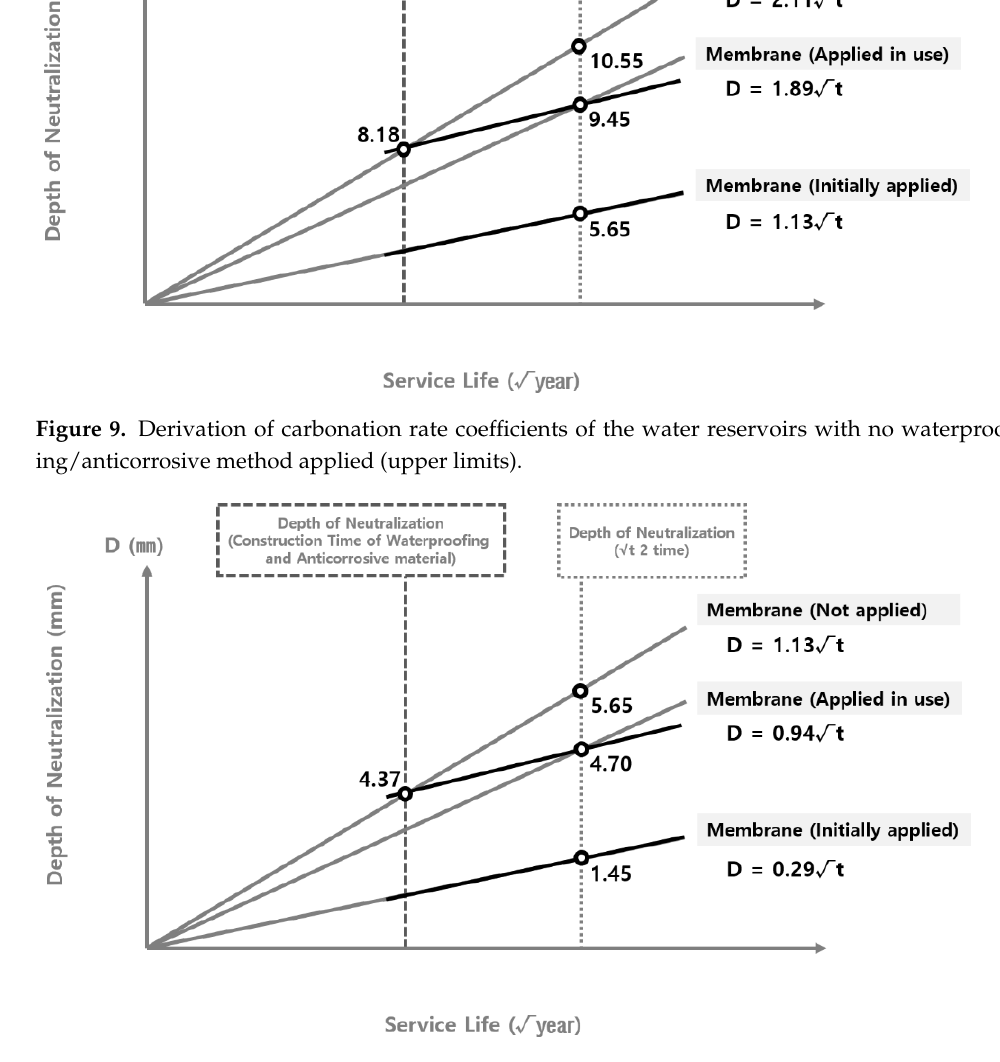
Figure 10. Derivation of carbonation rate coefficients of the water reservoirs with no waterproof- ing/anticorrosive method applied (lower ing/anticorrosive method applied (lower limits). Table 8. Carbonation rate coefficients according to the duration of waterproofing/anticorrosive method application.